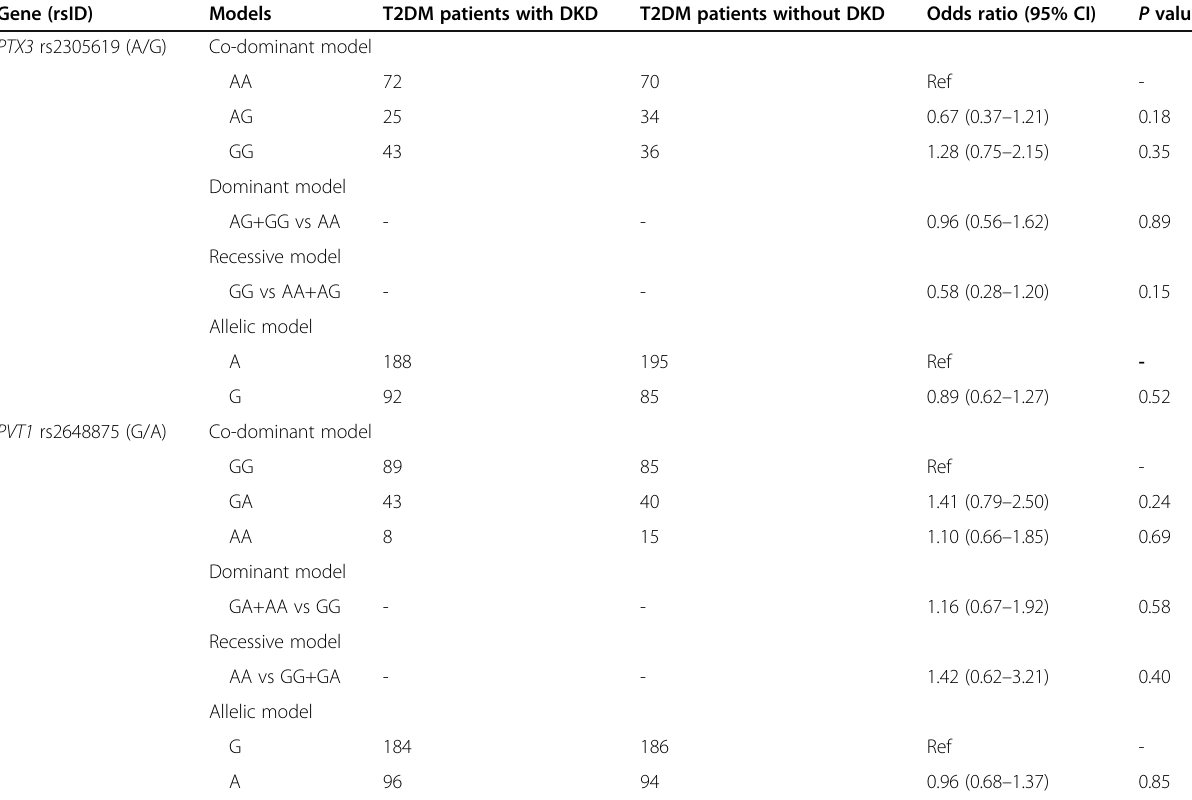
Table 5 Association of PTX3 and PVT1 gene polymorphism in T2DM patients with and without DKD